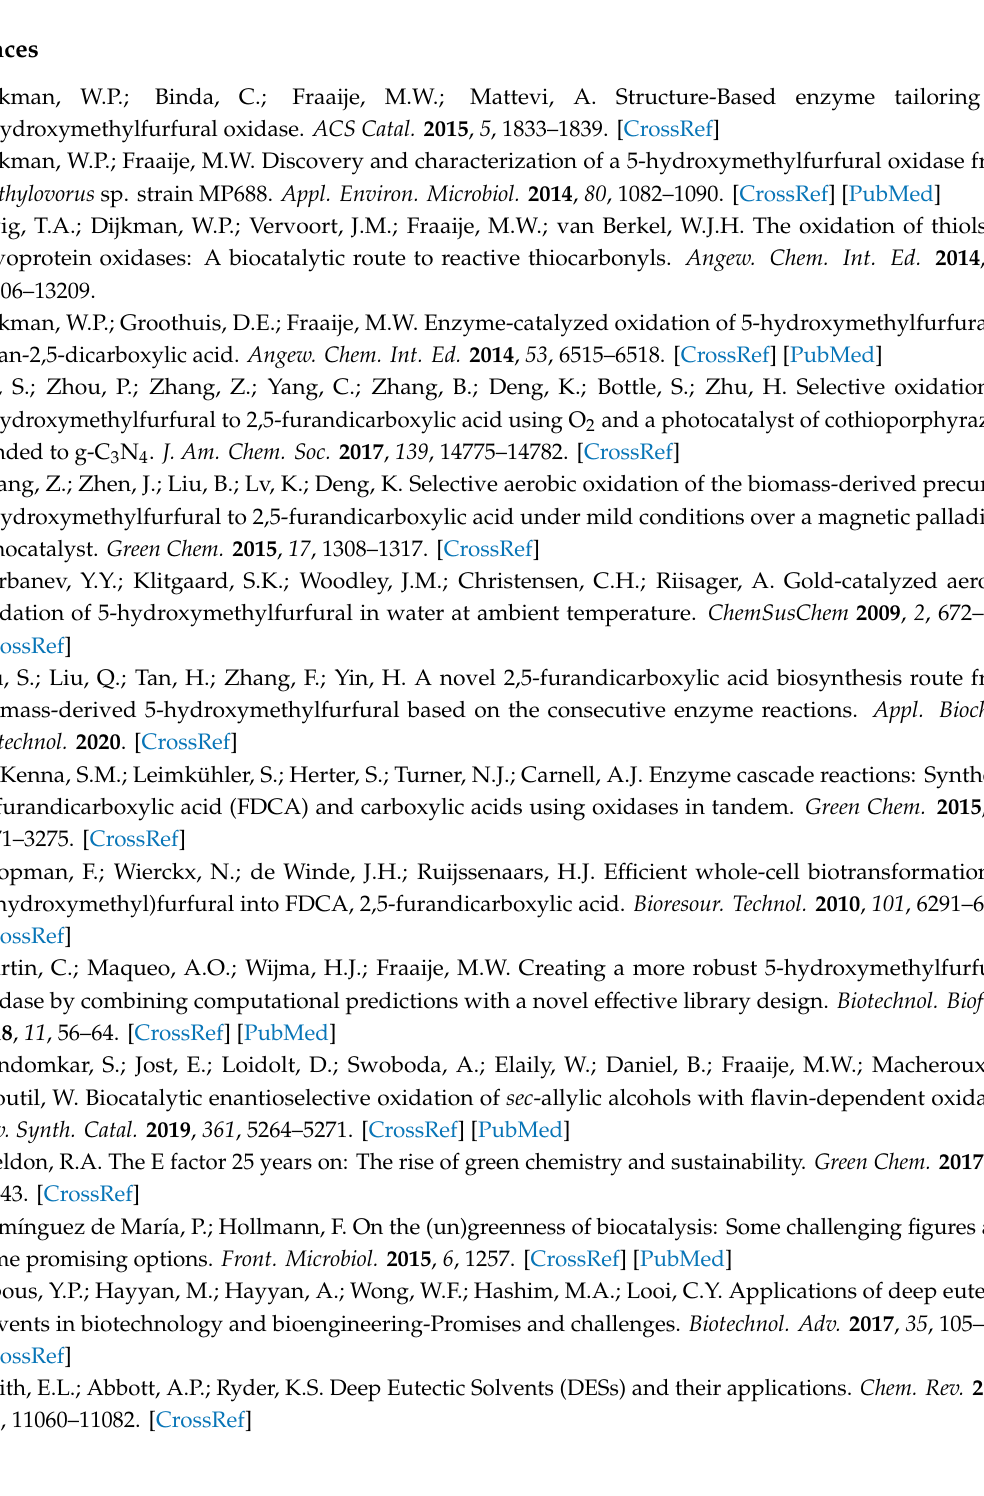
Table S1: Retention times at GC / MS analyses in the biooxidations of alcohols 1-12a , Table S2: Percentage of